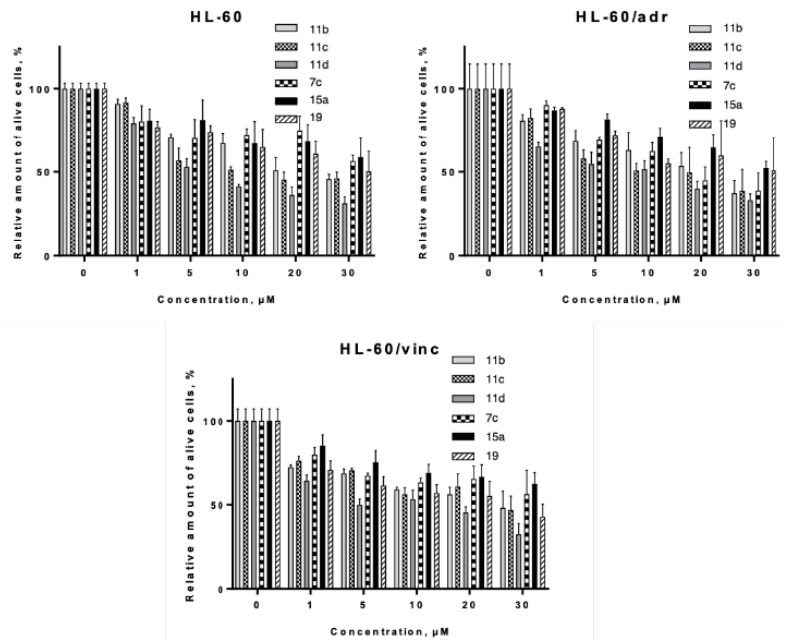
Figure 8. Evaluation of cytotoxic activity of selected CK2-HDAC dual inhibitors towards human leukemia cells of the HL-60 line and its drug-resistant sublines HL-60 / adr (MRP-1 overexpression) and HL-60 / vinc (P-glycoprotein overexpression). Trypan blue assay, 24 h incubation. Means and SD of at least three experiments in triplicate are shown.